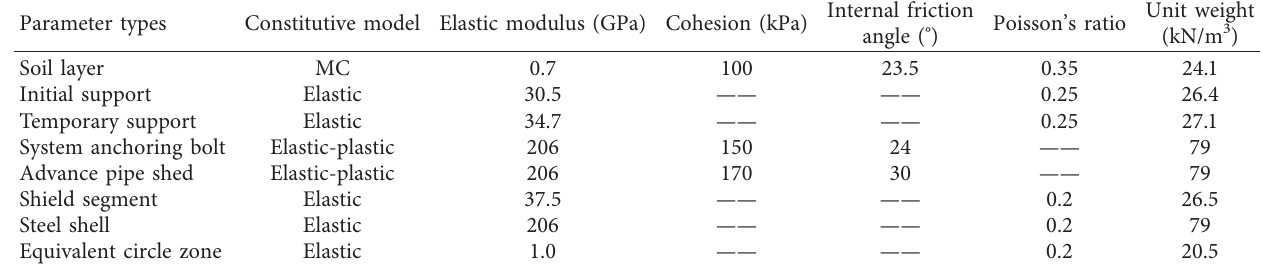
Table 7: Physical and mechanical parameters.